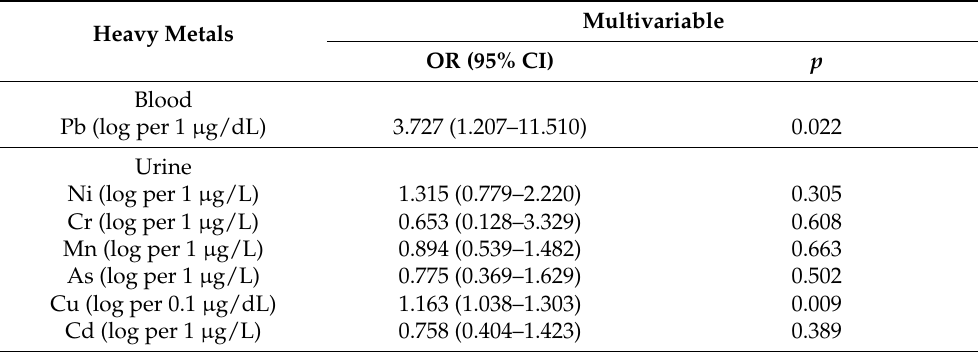
Table 4. Association of heavy metals with an eGFR of <60 mL/min/1.73 m 2 using multivariable logistic regression analysis.